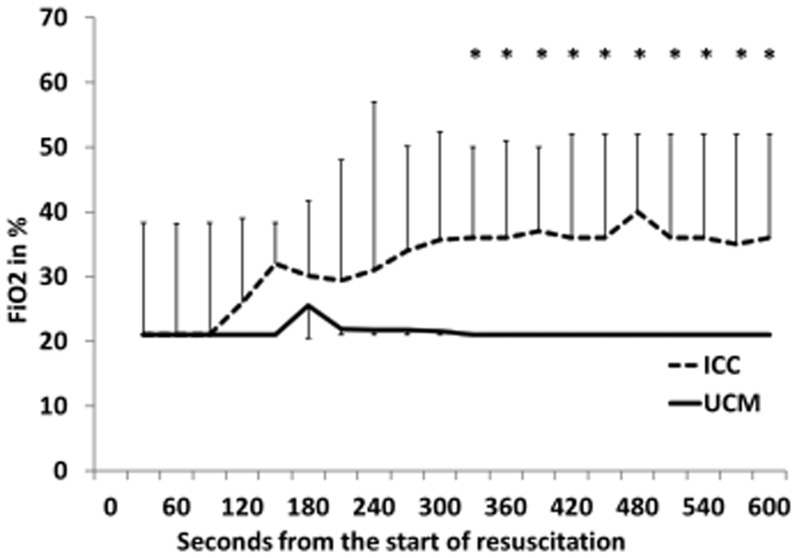
Changes in Inspired Fractional oxygen concentration (FiO2) over time in infants receiving umbilical cord milking (UCM) compared to im mediate cord clamping (ICC).The babies receiving UCM received significantly less supplemental FiO2 over the first 10 minutes of resuscitation (ANOVA, P = 0.04). *P<0.05 compared to ICC.